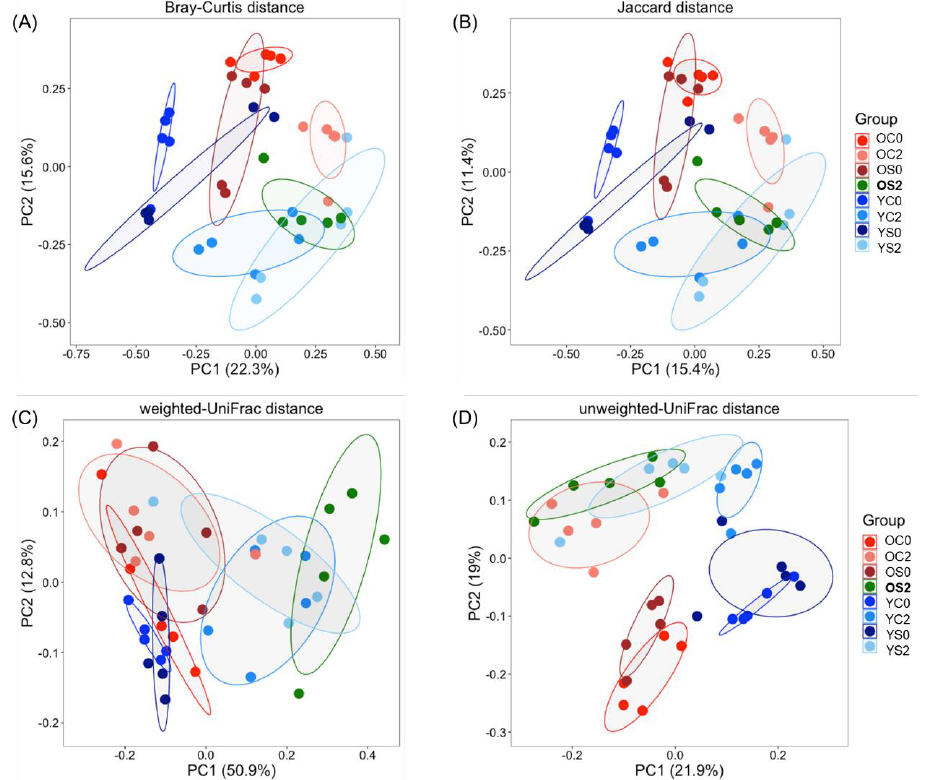
Figure 2. Principal Coordinate Analysis (PCoA) of the gut microbial communities in the different experimental groups. ( A ) Bray–Curtis distance, ( B ) Jaccard distance, ( C ) weighted-UniFrac distance, ( D ) unweighted-UniFrac distance. The individual samples are indicated by symbols according to age (old, young) and color-coded according to the groups. The colored ellipses indicate the 70% confidence interval of each group. The weighted-UniFrac distance accounted for the variance explained the most compared to other diversities. Notations of the groups are the same as in Figure 1.